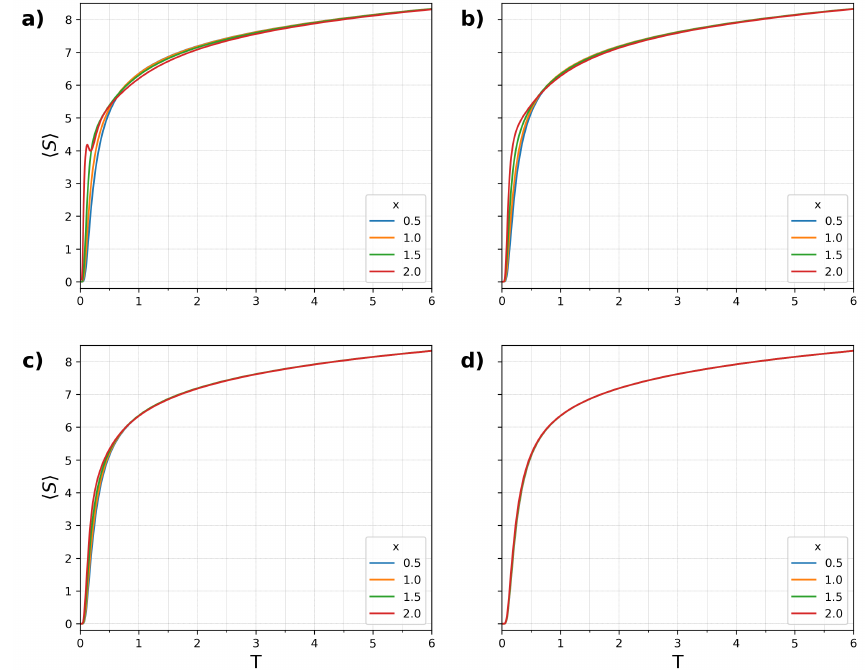
Figure 6. The behavior of the entropy is displayed as a function of the temperature. The curves correspond to different values of the dimensionless coupling constant x . From left to right, the values of x take the values 0.5, 1, 1.5, and 2, respectively. ( a – d ) stand for values of the asymmetry parameter